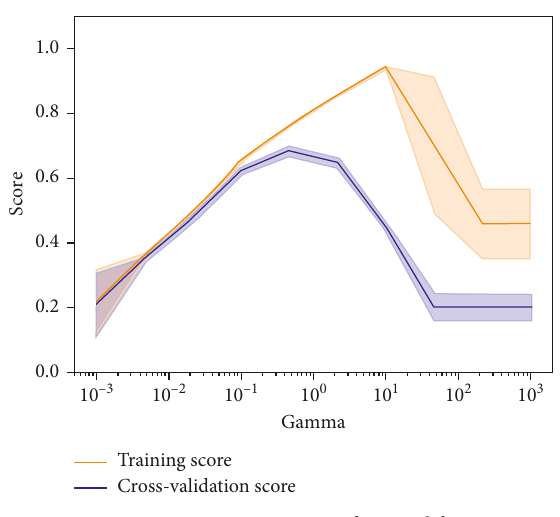
Figure 8: c -score curve of